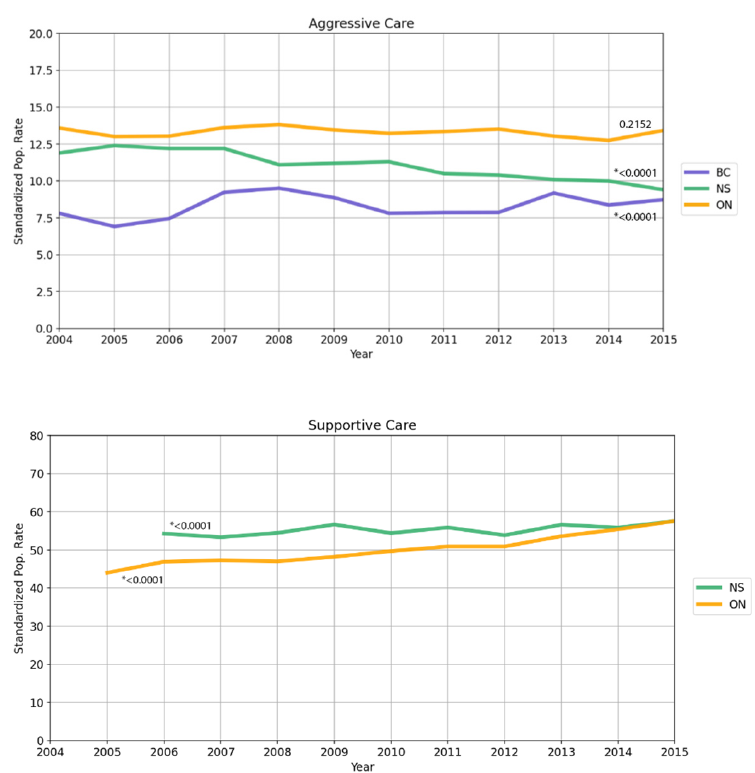
Figure 3. Aggressive care (top) and supportive care (bottom) data over time from 2004 to 2015. In Ontario, there was little overall change in the overall rate of receiving aggressive care (from 13.6% in 2004 to 13.4% in 2015). Aggressive care utilization dropped in this time in Nova Scotia from 11.9% in 2004 to 9.4% in 2015. British Columbia’s aggressive care utilization slightly increased from 7.8% in 2004 to 8.7% in 2015. Supportive care use rose in Ontario from 44% in 2004 to 57.6% in 2015. Nova Scotia’s utilization slightly increased from 54.3% in 2006 to 57.6% in 2015. p -values reported are from the Cochran–Armitage trend test (two-sided); * denotes values that are statistically significant. Ontario does not have reported data for 2004 and Nova Scotia does not have data for both 2004 and